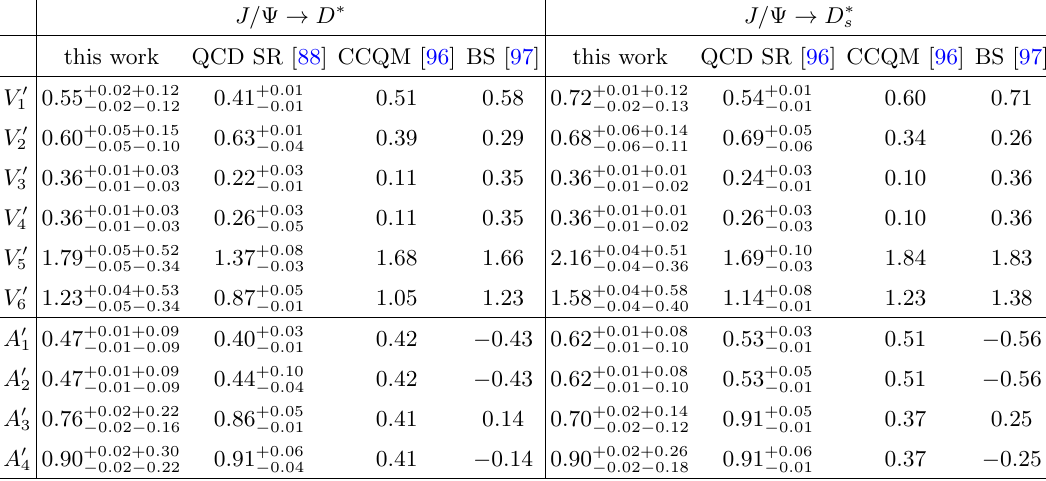
transitions at s